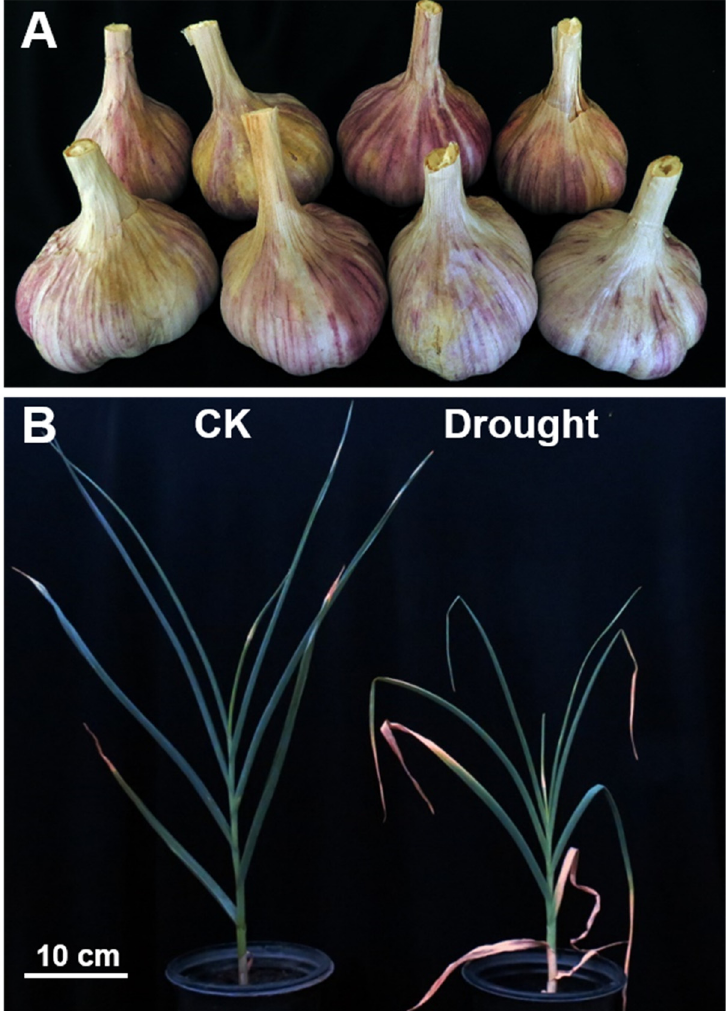
Figure 1. Garlic cultivar (Purple Glazer) used in this study. ( A ). Garlic bulbs with purple skin. ( B ). Garlic plants grown under normal conditions (CK) and drought stress.